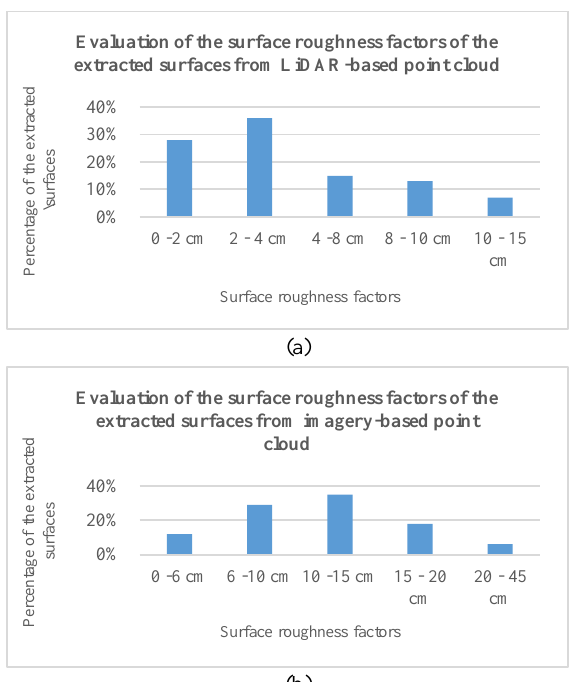
Figure 14. Two different views of a photo-realistic 3D model generated from airborne photogrammetric